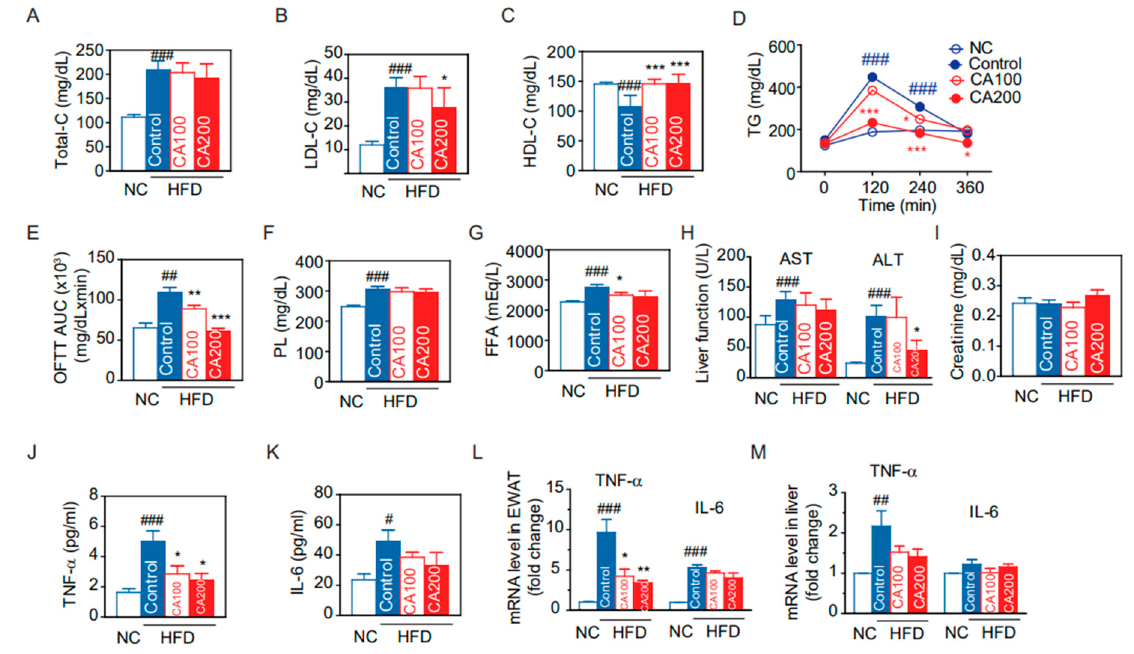
Figure 3. Changes of lipid and metabolic profiles by CA in HFD mice: ( A ) total-cholesterol (Total-C), ( B ) LDL-cholesterol (LDL-C), ( C ) HDL-cholesterol (HDL-C), ( D ) time course of serum TG in oral fat tolerance test (OFTT), ( E ) area under the curve (AUC) of OFTT, ( F ) phospholipids, ( G ) free fatty acid (FFA), ( H ) liver function marker enzyme activities of AST and ALT, ( I ) creatinine, and ( J , K ) ELISA. Serum protein levels of TNF- α ( J ), and IL-6 ( K ). ( L , M ) Real-time qRT-PCR. TNF- α and IL-6 mRNA levels in EWAS (L) or liver (M). Data are expressed as the mean ± SEM ( n = 5). # p < 0.05, ## p < 0.01, ### p < 0.001 vs. NC, and * p < 0.05, ** p < 0.01, and *** p < 0.001 vs. HFD-control. NC, normal chow; Control, HFD-control; CA100, HFD plus CA 100 mg/kg; CA200, HFD plus CA 200 mg/kg.